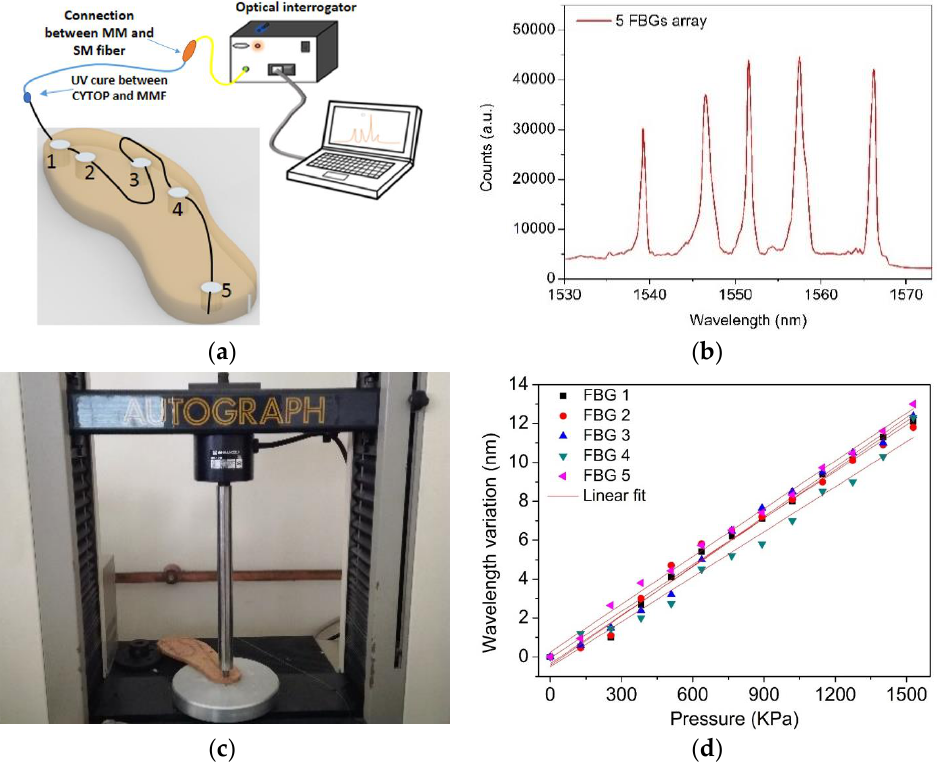
Figure 3. ( a ) Schematic representation of the monitoring system. ( b ) Reflected optical spectrum of the five-sensor FBG array after integrated in the cork insole; ( c ) photograph of the pressure testing platform with the cork insole; ( d ) calibration results of the POFBGs to pressure (points are the experimental values and lines refer to the linear fits, (0.982 < R 2 < 0.994). Table 1. Pressure sensitivities obtained for the sensor characterization.